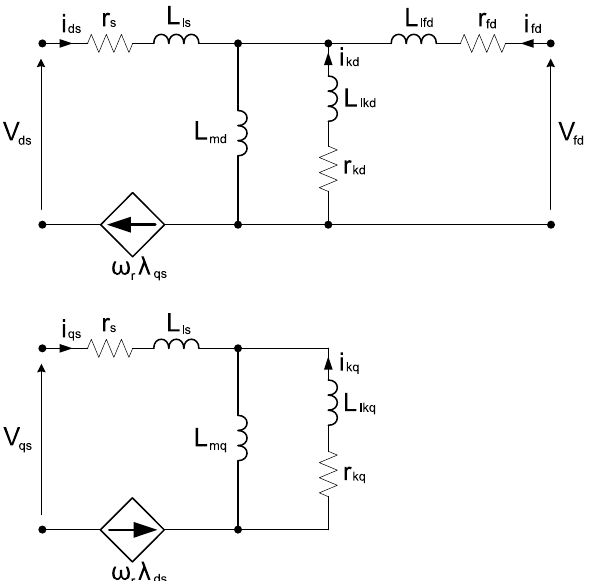
Figure 1. Classical equivalent circuits of a synchronous generator connected to RL electric load (axes d and